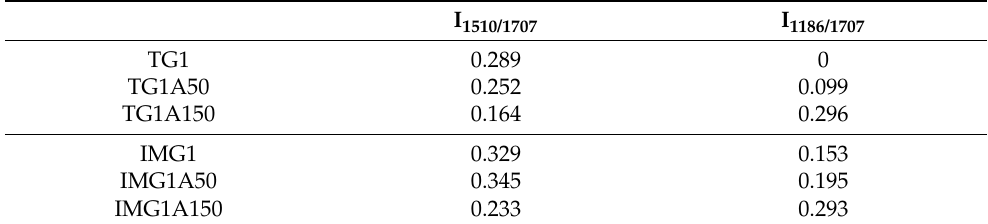
Table 3. Intensity ratio of relevant cross-linking peaks of thiophene and imidazole with